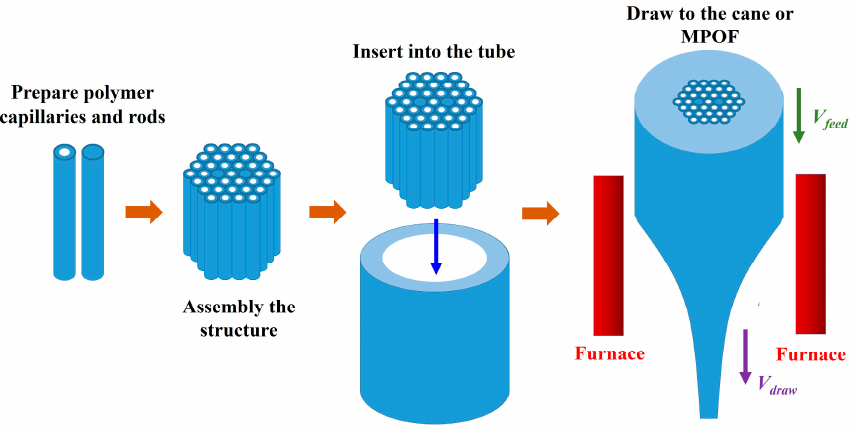
Figure 2. Schematic the stack-and-draw method use to fabricate microstructured polymer optical fibers (MPOFs) and their preform.